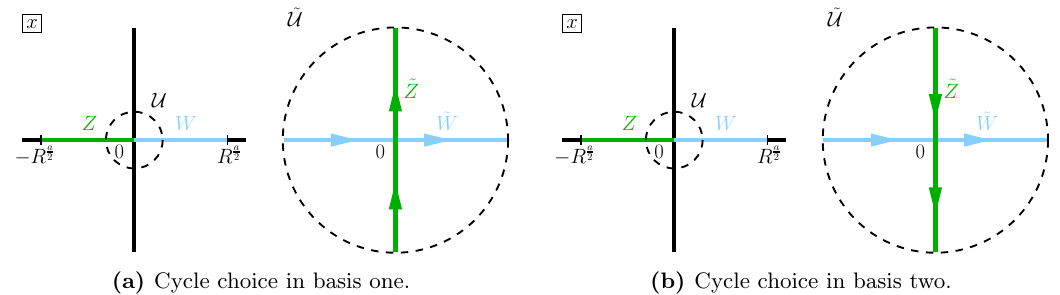
Figure 3. In this (cid:12)gure we illustrate two di(cid:11)erent choices of bases for the cycles in the x - and y -plane for the g